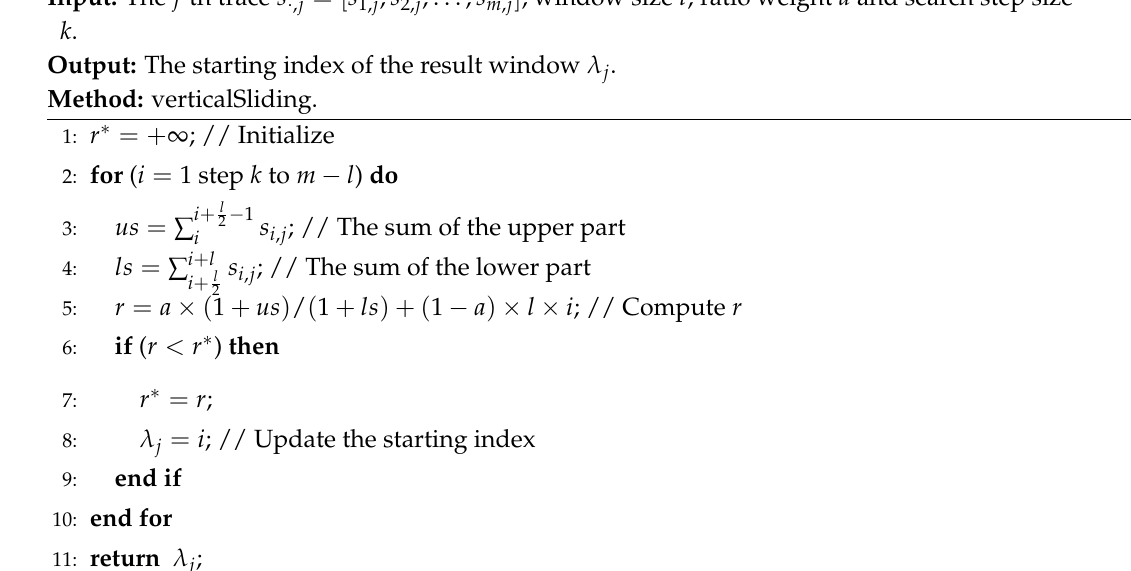
Algorithm 1: Vertical Window Sliding for One